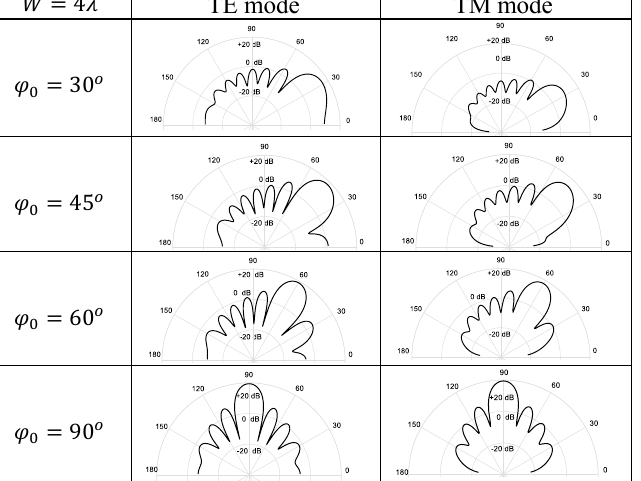
Fig.6. Bistatic echowidth patterns for 𝑊 = 4𝜆 at various the angles of incidence 𝜑 = 30 (cid:135) , 45 (cid:135) , 60 (cid:135) and 90 (cid:135) A